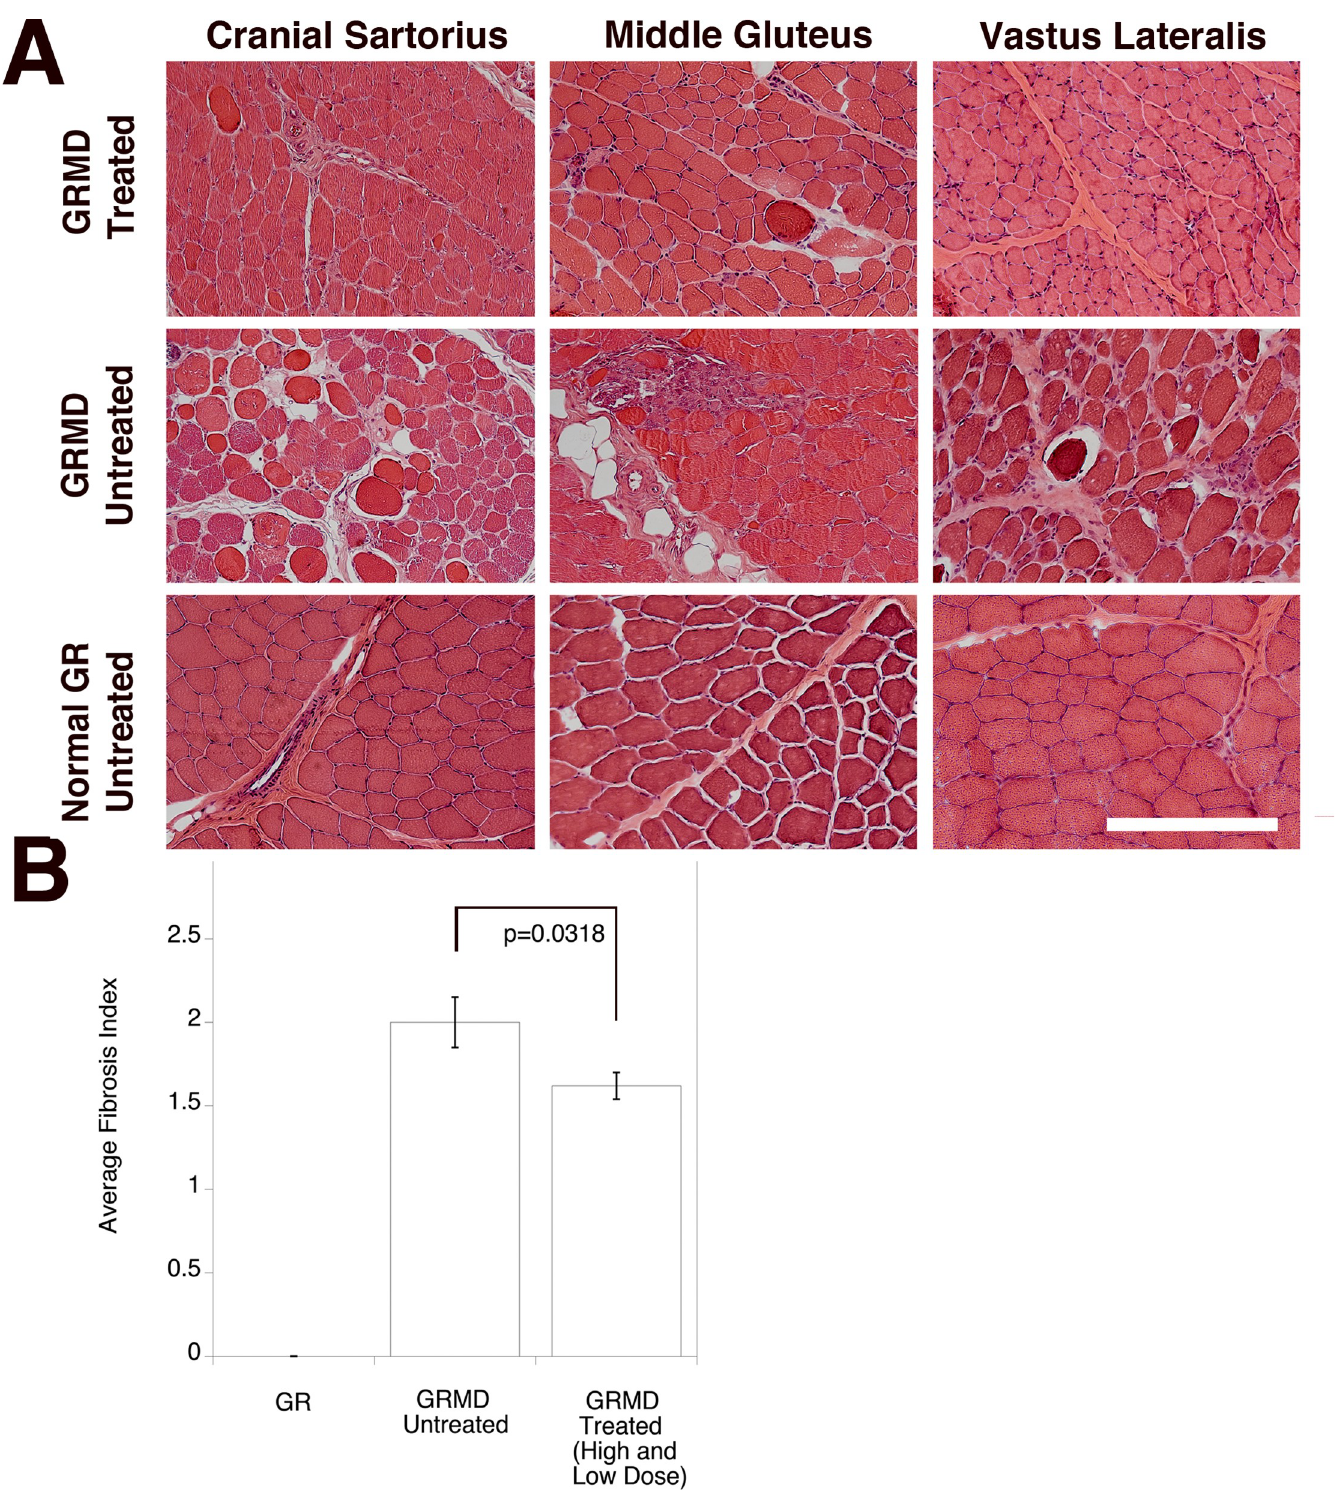
Fig 4. Skeletal muscle pathology in rAAVrh74.MHCK7. GALGT2 -treated GRMD dogs. (A) Cranial sartorius, middle gluteus, and vastus lateralis muscles were cut in cross-section from 6-month-old untreated normal GR, untreated GRMD, and treated GRMD (treated with low dose, 2x10 14 vg/kg rAAVrh74.MHCK7. GALGT2 at 3 months) dogs. Sections were stained with H&E. Bar is 200 μ m. (B) Measures of fibrotic index for skeletal muscles from wild type golden retriever (GR) and golden retriever muscular dystrophy (GRMD) dogs, either untreated or treated (pooled low dose [2x10 14 vg/kg] plus high dose [6x10 14 vg/kg]) with rAAVrh74.MHCK7.